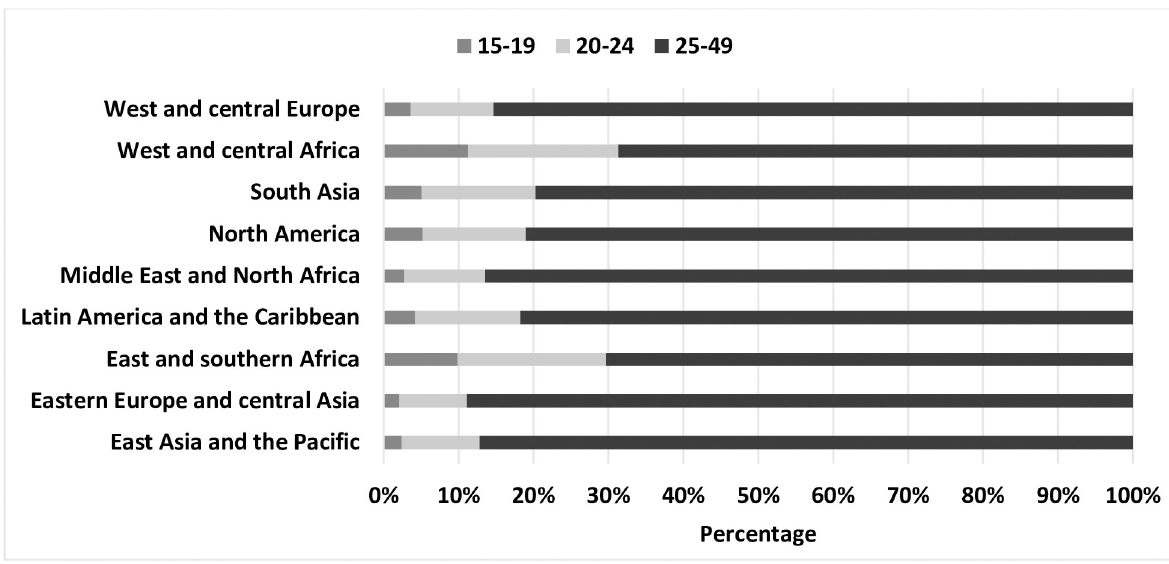
The size estimates presented here provide national programmes with data to plan the scale of youth-friendly services. These data also provide evidence for the need to increase flexibility with age limits for HIV and sexual/reproductive health services and treatment, especially for the most vulnerable adolescent populations. This publication offers an initial step in producing usable estimates of the size of adolescent and young vulnerable populations; however, several inconsistencies and limitations in these findings warrant caution in their use. WHO, UNAIDS and GFATM jointly assessed size estimates available by the end of 2019, only 41 countries for males who have sex with males and 19 countries for females who sell sex were deemed to have “nationally adequate” estimates, meaning that they are empirically derived and/or reflect geo- graphic coverage of > 50% of the population [1]. Given the importance of size estimates among adolescent and young key populations, as well as adult key populations, more attention